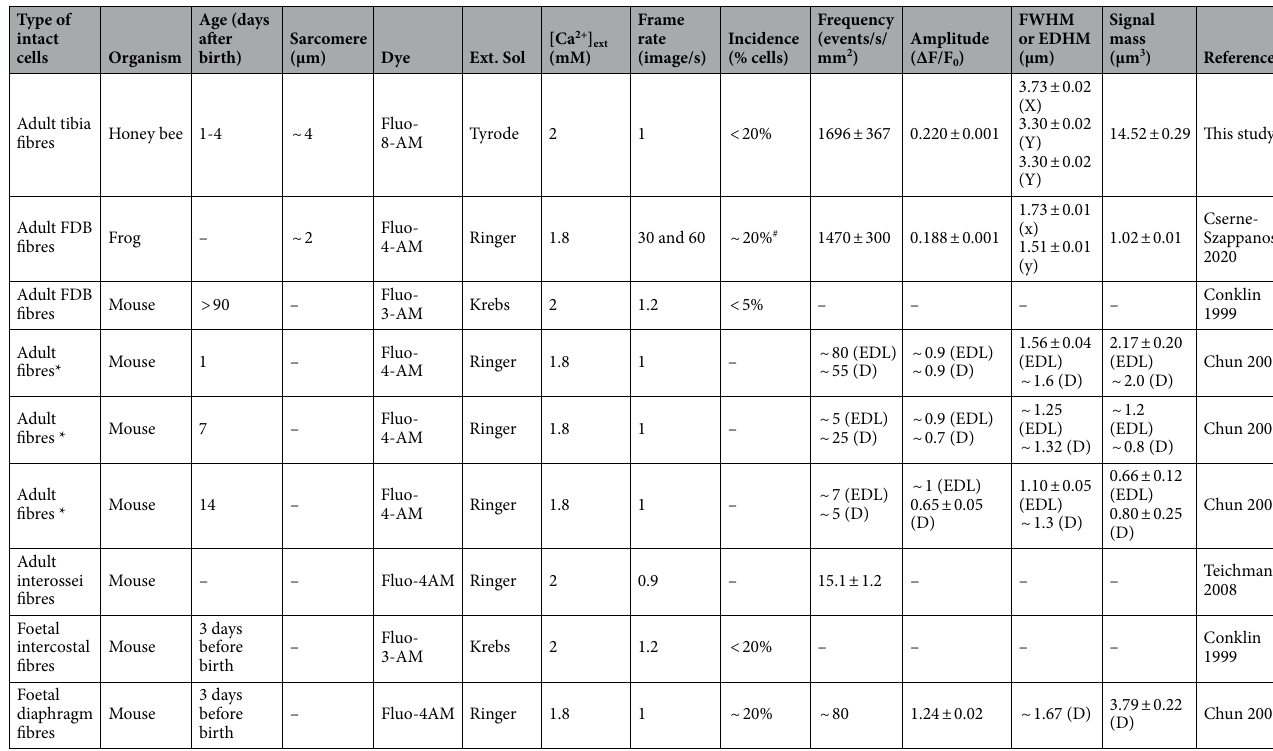
Table 2. Interspecific comparison of calcium sparks’ parameters measured in two dimensional (XY) experiments made in intact cells. In this table studies are ordered according to i) the developmental stage (from adult to foetal stages) and ii) the species (Honey bee, Frog and Mouse). All cells were freshly isolated muscle fibres. *Chun values are from adult P1, P7 and P14 diaphragm (D) and EDL muscle. Foetal diaphragm is from E18, I.e. 3 days before birth. # Personal communication. Data marked with ~ is approximated from figures. All data depicted at room temperature. FDB – flexor digitorum brevis; EDL – extensor digitorum longus; D- diaphragm; AM – acetoxymethyl ester; FWHM – full width at half maximum; EDHM – equivalent diameter at half